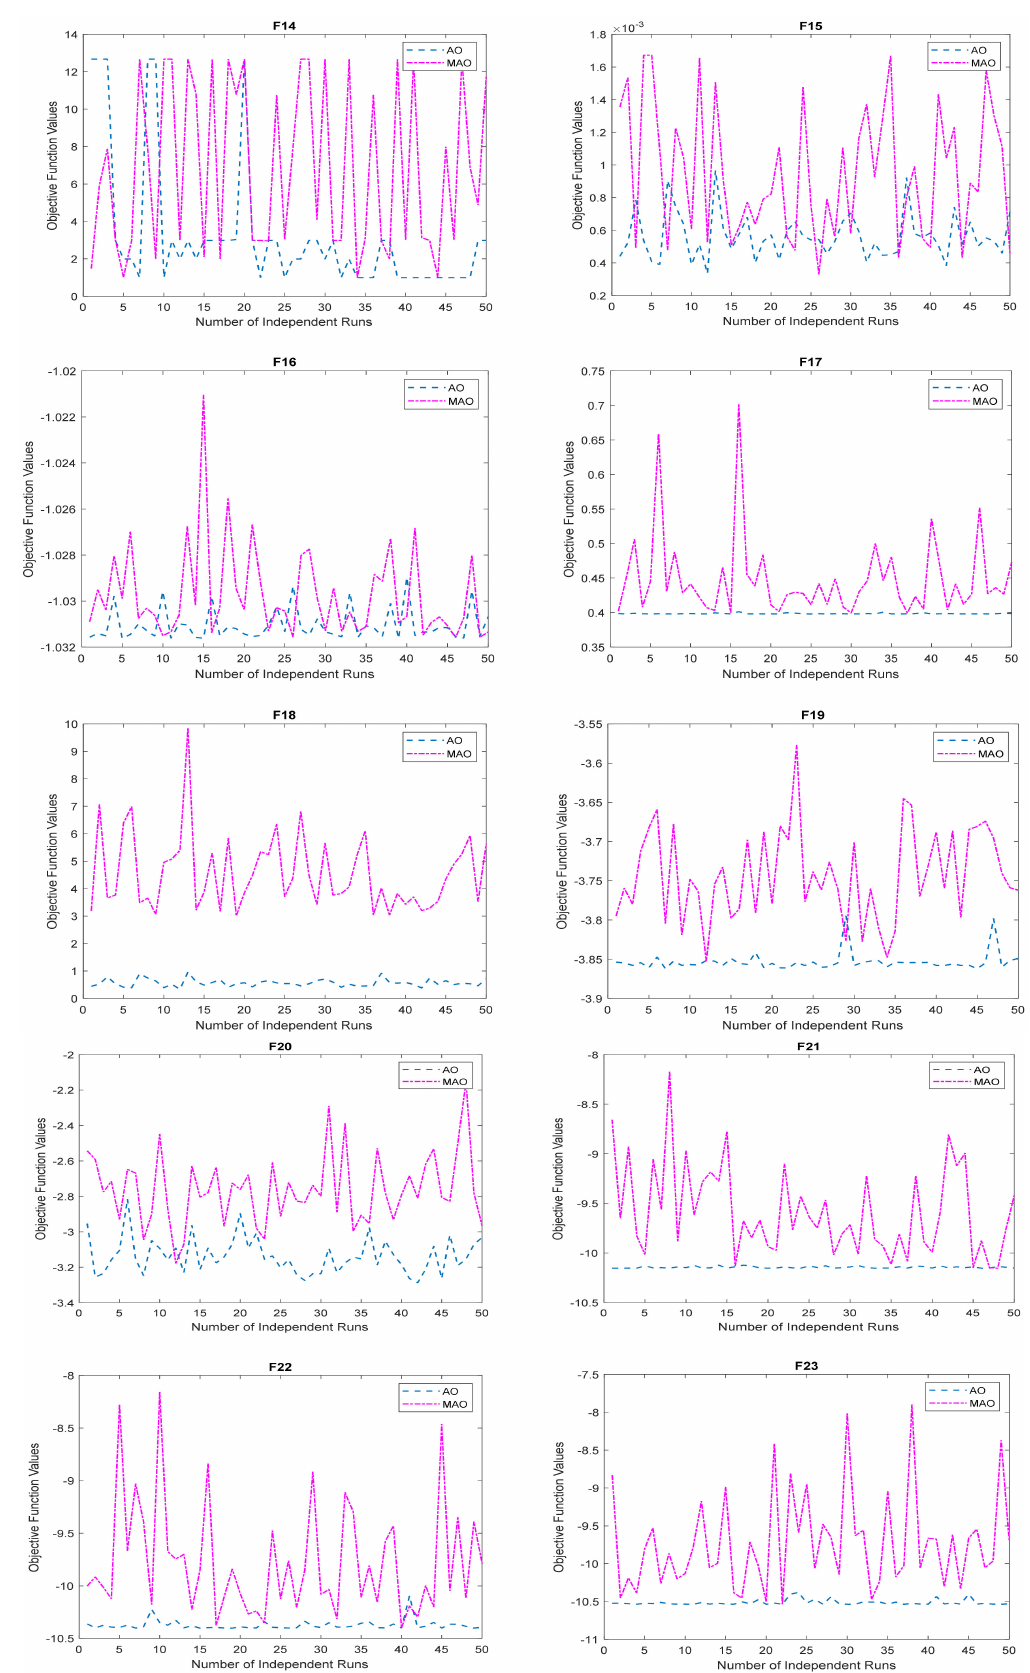
Figure 10. Independent runs of fixed-dimensional benchmark functions with D =